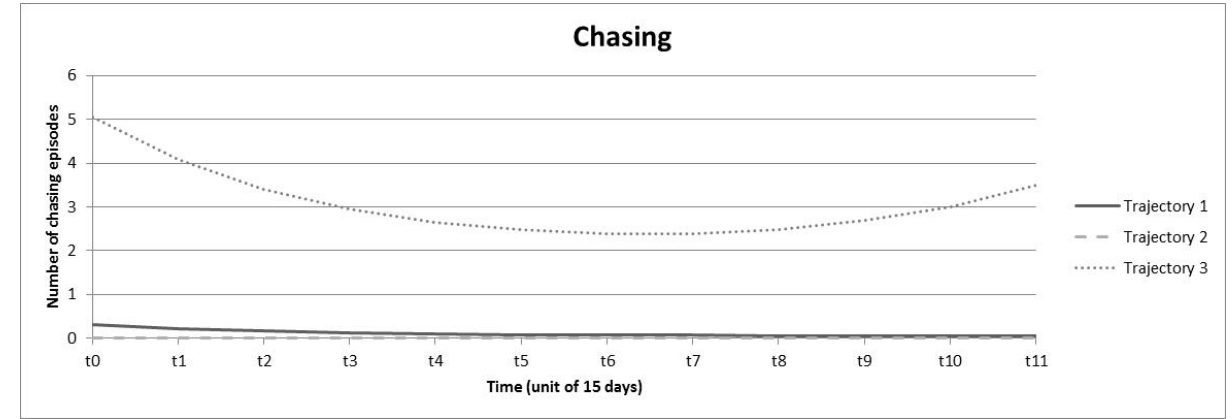
Figure 4. Trajectories obtained from growth mixture models for chasing.